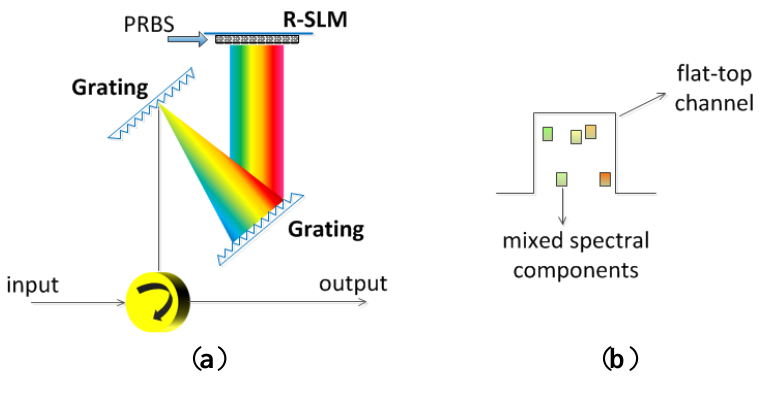
Figure 11. Compressive sensing improves the operational bandwidth of the DFT-based microwave spectrum sensing system. ( a ) Schematic of compressive sensing module based on optical random mixing using a reflective spatial light modulator (R-SLM) with a pseudo-random bit sequence (PRBS) input. ( b ) Illustration of sample-and-hold integration by spectral filtering in the optical